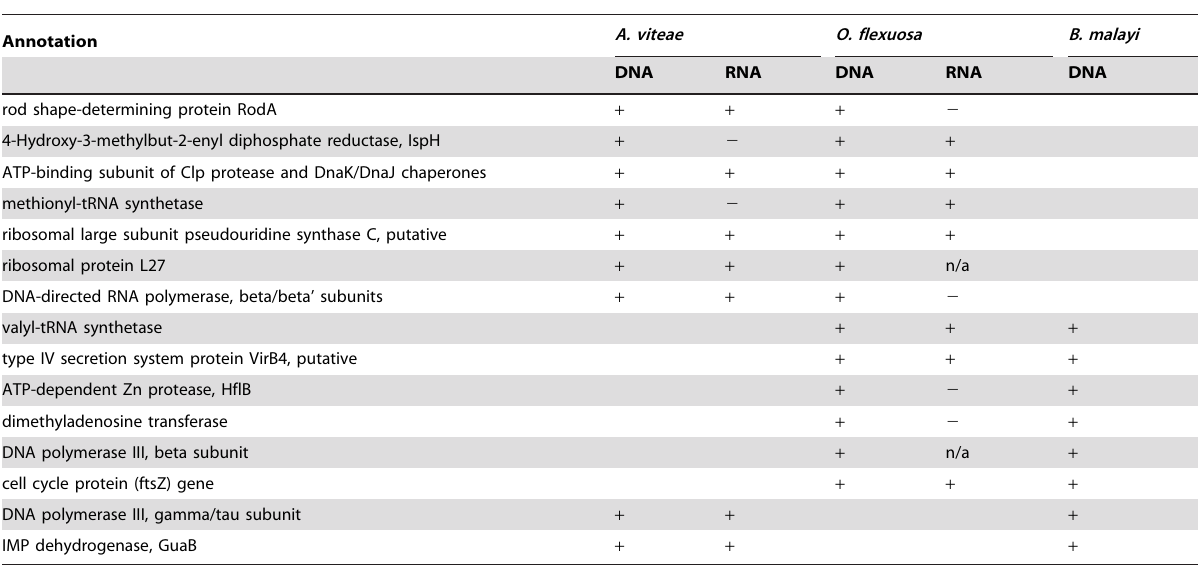
Table 2. Wolbachia homologs found in multiple